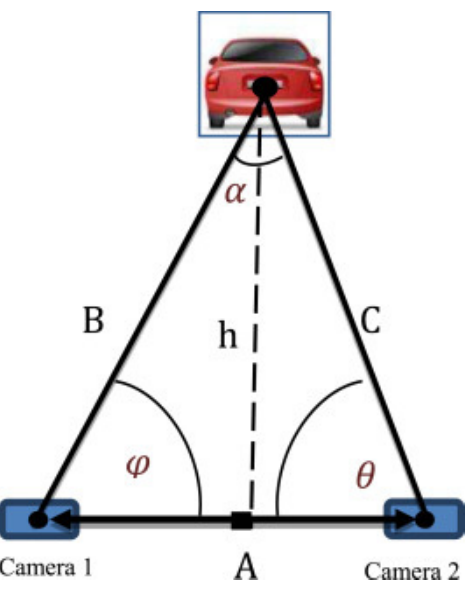
Figure 3. Stereovision system for distance estimation [52].